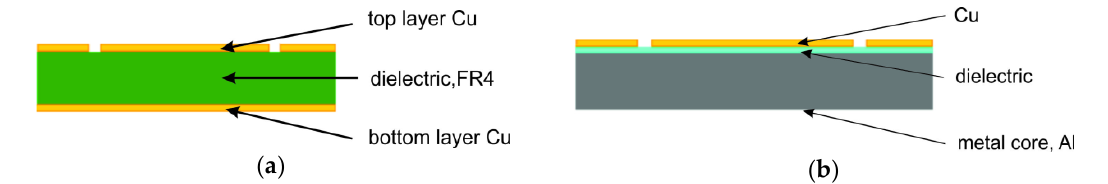
Figure 16. Exemplary structure of circuits: ( a ) printed circuit board (PCB) and ( b ) metal core PCB (MCPCB).